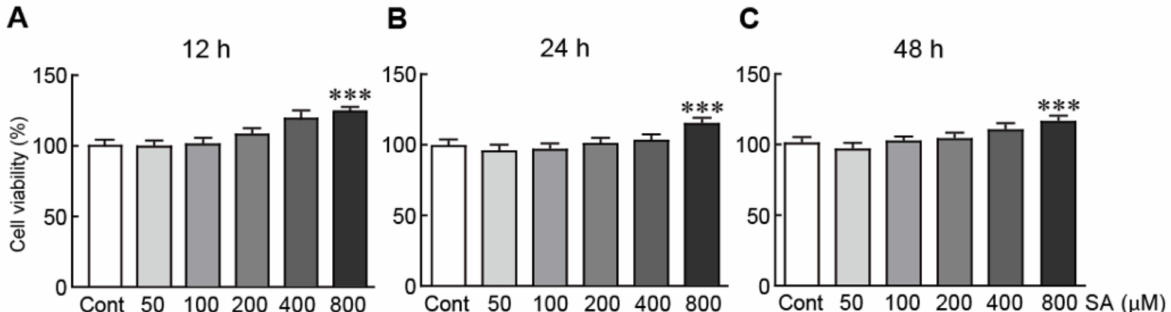
Figure 1. Cytotoxic effects of SA on SH-SY5Y neuroblastoma cells. Cell viability was measured via the MTT assay. The cells were pretreated with 50, 100, 200, 400, and 800 µ M SA for 12 ( A ), 24 ( B ), and 48 h ( C ). The columns and error bars represent the mean ± standard error of the mean (SEM) from three independent experiments. Significance was determined via one-way ANOVA coupled with Bonferroni’s post hoc test. *** p < 0.001 vs. control group. Cont, control; SA, sinapic